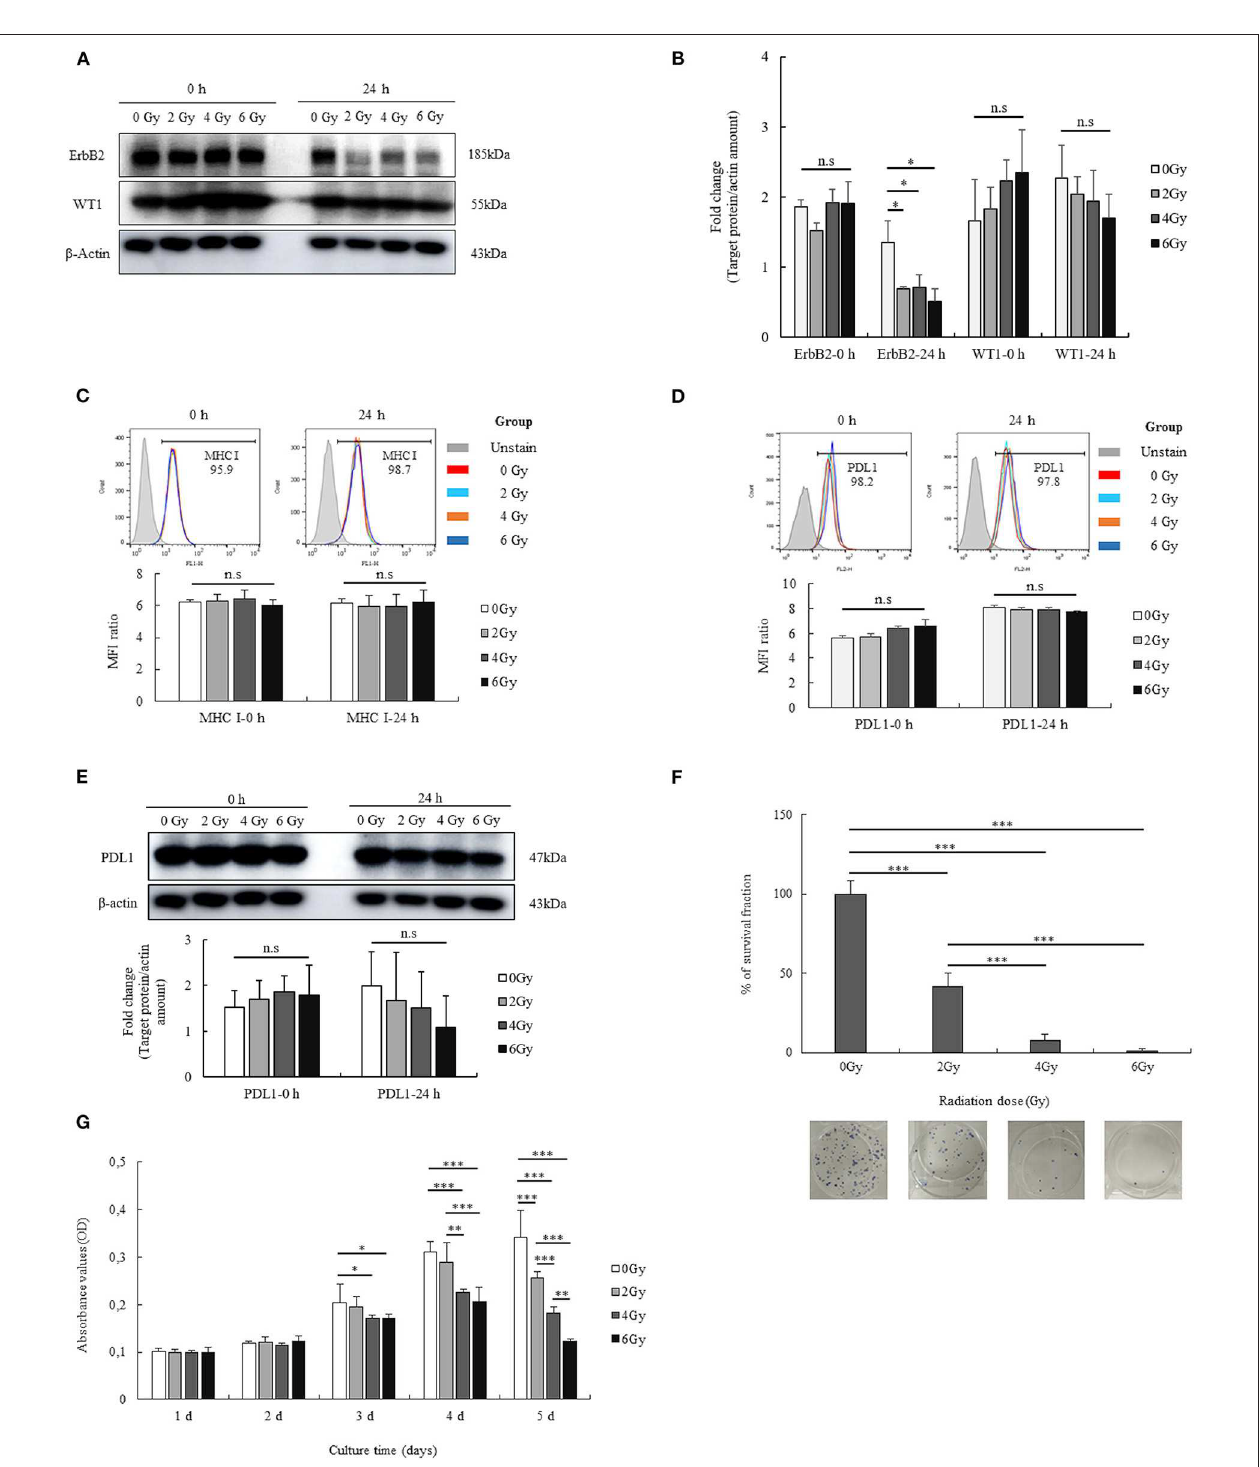
FIGURE 1 | Immunological characterization of the GL261 cell line, and the effects of radiation. The expression of two tumor-associated antigens (ErbB2 and WT1) on GL261 cells and the short-term effects of radiation on the expression of these proteins were confirmed by western blot analysis (A) . Fold changes in protein signals are summarized by bar charts (B) . The expression of MHC I on GL261 cells and the short-term effects of radiation on this expression were also confirmed by flow cytometry (C) . The surface expression and total protein expression of PDL1 on GL261 was estimated by flow cytometry and western blot (D,E) . Moreover, the effects of radiation (2, 4, and 6Gy) on the viability and proliferation of GL261 cells were also clarified by clonogenic assay and MTT assay (F,G) . Data is summarized by bar charts as the mean ± standard deviation (SD). All data are represented as the mean of two independent experiments. β -Actin was used as an internal control, and the figure is composed of multiple gel images. Full-length blots are presented in Figure S2 . GL261, mouse glioblastoma cell line; H-2Kb, MHC class I expression in mice. * p < 0.05; ** p < 0.01; and *** p < 0.001; n.s., no significant difference.